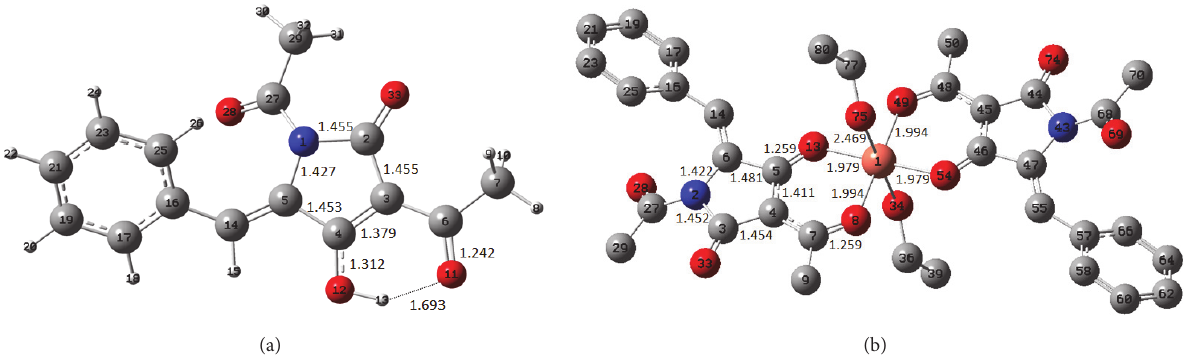
Figure 4: Ball and stick draws of the optimized structures: (a) N-acetyl-3-acetyl-5-arylidenetetramic acid (TA) and (b) copper(II) complex [Cu(TA-H + ) 2 (EtOH) 2 ]. In Figure (b) hydrogen atoms have been omitted for clarification. Main bond lengths and atoms’ number are labeled. Calculations have been performed at B3LYP/TZVP level of theory.